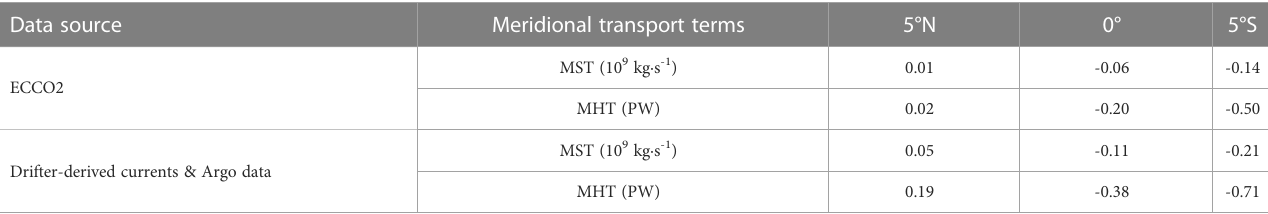
TABLE 1 Annual means of the MST and MHT. The western boundary of the integral is 90°E. Positive values are northward transports. Data